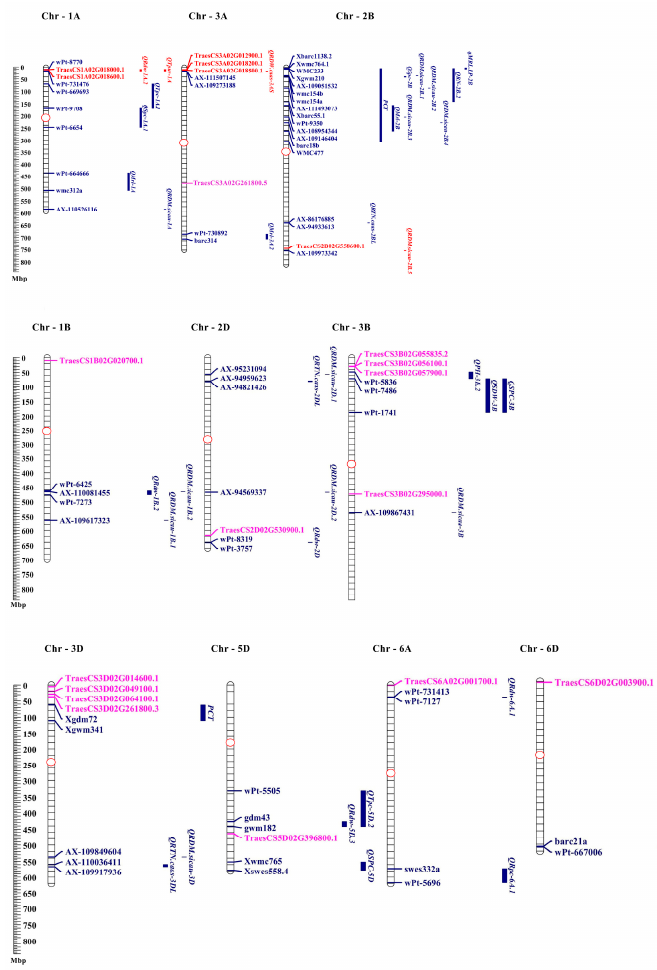
Figure 7. Co-localization of six TaPSTOL1 orthologs on three chromosomes, i.e., 1A, 3A, and 2B. Scale on the left-hand side shows the physical position of these genes in Mbp. Genes located within the QTLs are illustrated with red color, while genes and QTLs not linked are represented with pink and blue colors. Red circle represents the centromere position.